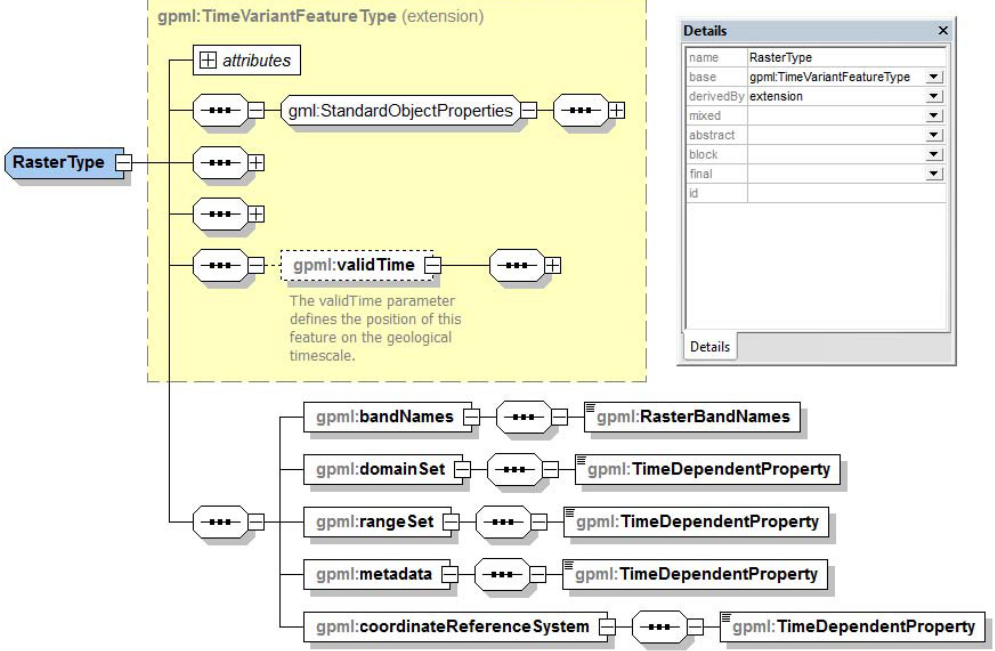
Fig. 26. Schema diagram for gpml:Raster